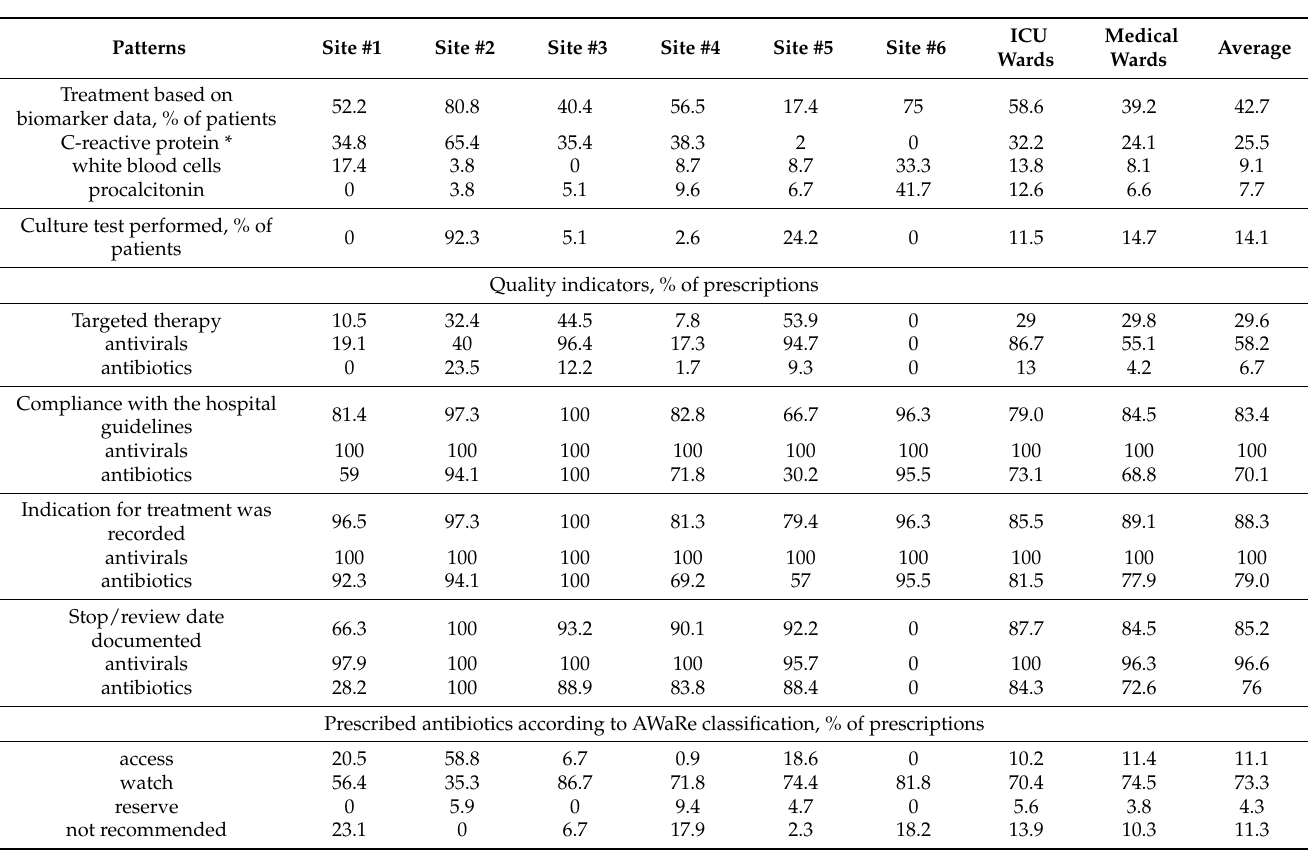
Table 5. Key patterns and quality indicators of systemic AMD prescribing for the treatment of